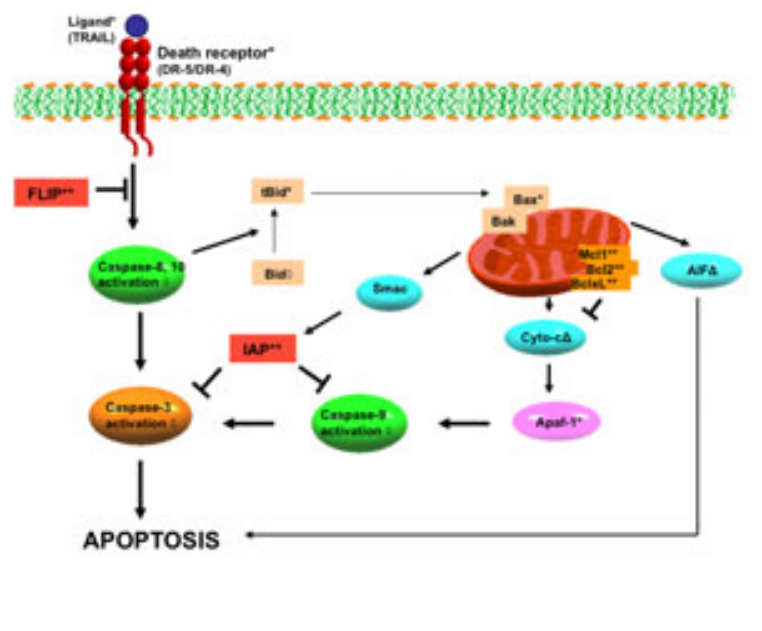
Figure 1. Induction of the extrinsic and intrinsic apoptotic pathway by HDACi in myelo- ma cells. The extrinsic apoptotic pathway is triggered by ligand binding and leads to acti- vation of caspase-8, which, in turn, activates caspase-3. Activation of the intrinsic apop- totic pathway results in the release of three compounds: (a) cytochrome-c (cyto-c) which binds to apoptotic protease activating factor (Apaf-1) to activate caspase-9, (b) apoptosis inducing factors (AIF) and (c) second mitochondria-derived activator of caspase (Smac). FLICE-like inhibitory protein (FLIP) and members to the inhibitors of apoptosis (IAP) are able to prevent apoptosis induced by death receptors or intrinsic pathway respective- ly. Symbols denote compounds that are up-regulated (*), down-regulated (**), activated ( ∏ ) or translocated to cytosol ( r ) by HDACi in myeloma